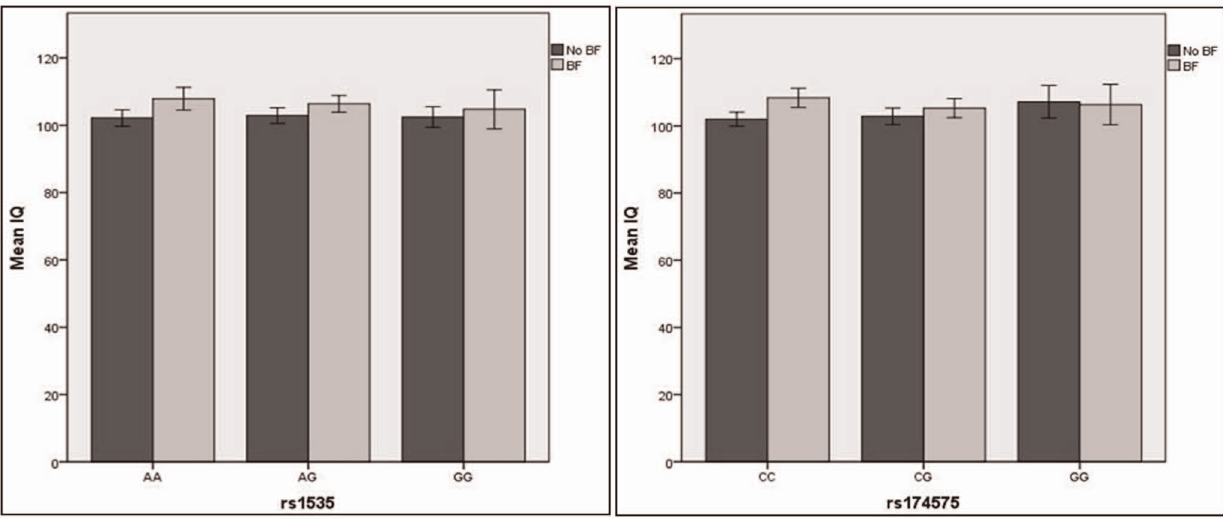
Figure 2. Unadjusted means for Full-scale IQ at 10 years for BF and child FADS2 rs1535 and rs174575 genotypes. Error bars denote + / 2 2 Standard Errors of the